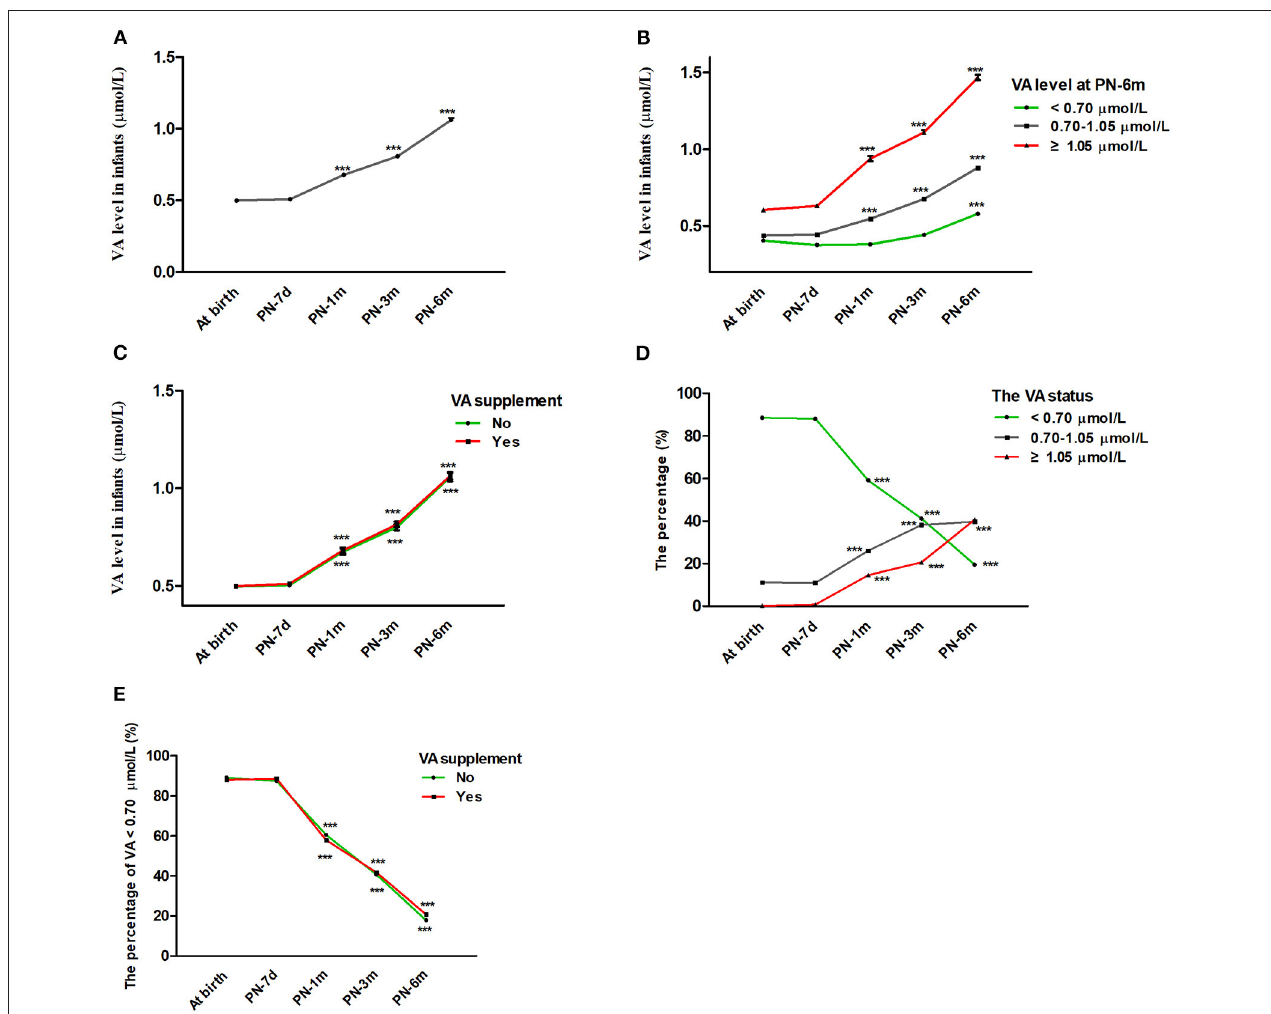
FIGURE 2 | Changes in infant VA status throughout the first 6 months of life. (A) Changes in VA levels in infants with age from birth to 6 months. (B) Change in VA levels in infants with age after stratification by VA levels at 6 months (VA < 0.70, 0.70–1.05, ≥ 1.05 µ mol/L). (C) Change in VA levels in infants with age after stratification by vitamin A supplementation. (D) Changes in VA distribution (VA < 0.70, 0.70–1.05, ≥ 1.05 µ mol/L) in infants with age. (E) Percentage of infants with VA < 0.70 µ mol/L vs. age after stratification by vitamin A supplementation. The values are the mean ± SEM (A–C) or percentage (D,E) . Generalized estimating equations with Bonferroni post hoc test. *: significant difference with the last visit (*** p < 0.001). VA, vitamin A; PN-7d, postnatal day 7; PN-1m, postnatal month 1; PN-3m, postnatal month 3; PN-6m, postnatal month